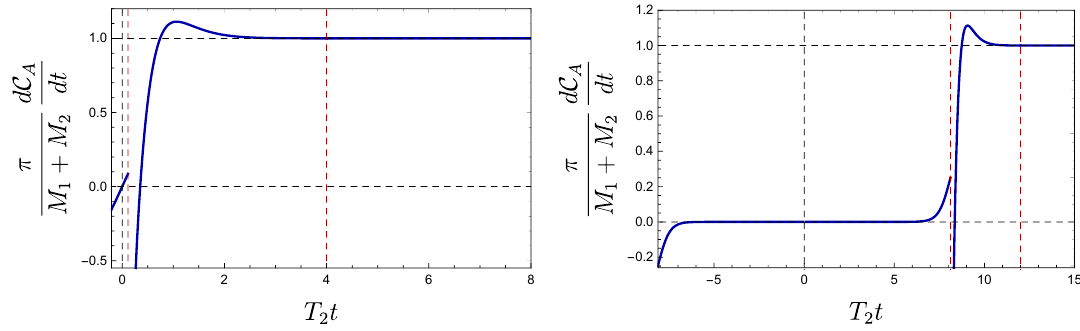
t Figure 2. Time derivative of complexity, evolving both boundaries as t with T 2 t w = 2 L = t R = 2 (left) and T 2 t w = 6 (right). We have set w = 1 + 10 (cid:0) 5 and ~ ‘ ct = 1. The condition on z implies that the smaller black hole is at the Hawking-Page transition, for both cases. The lower horizontal dashed line (near zero) corresponds to ( M 2 M 1 ) = ( M 2 + M 1 ), and by construction, the late time (cid:0) limit approaches 1 at the higher horizontal line. The horizontal axis in both (cid:12)gures starts from the respective t c 0 in eq. (3.60). The (cid:12)rst vertical black dashed line appears at t = 0, while the vertical red dashed lines appear at t c 1 (left) and t c 2 = 2 t w (right), see also eq. (3.60). There is a negative spike right after t c 1 , where x m is close to the past singularity. For the earlier shock wave in the right (cid:12)gure, there is a long regime where the rate of change is close to zero. In both cases, the late time limit is approached from above.